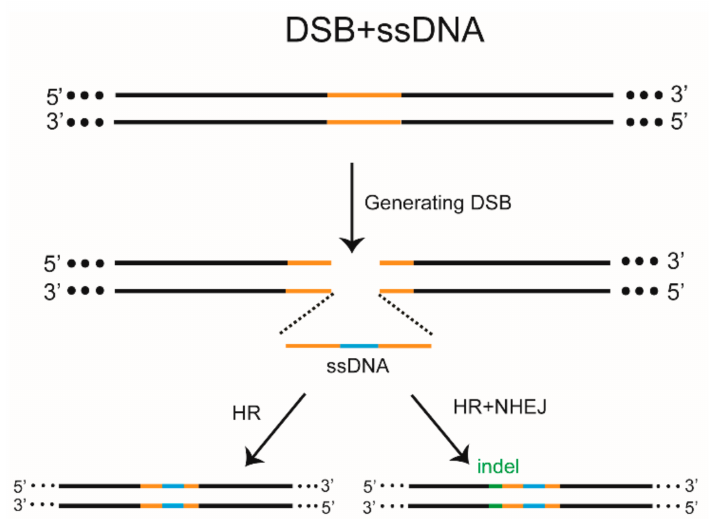
Figure 1. Double-strand breaks (DSB) and single-stranded DNA (ssDNA) mediated gene editing